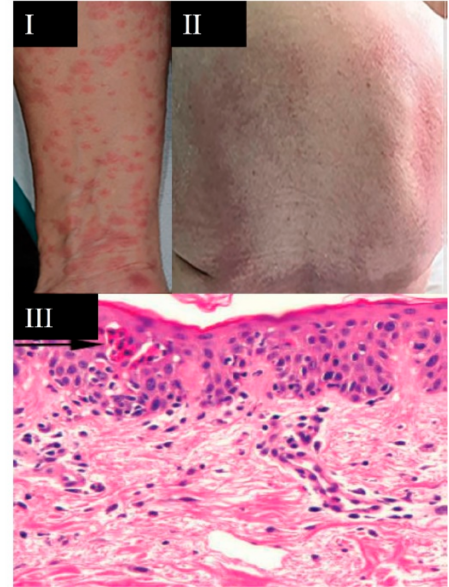
Figure 8. Maculopapular-erythematous rash. ( I ) Maculopapular lesions described as small plaques after fusion of the lesions; ( II ) maculopapular rash appearing on the posterior trunk; ( III ) skin biopsy showing clusters of apoptotic keratinocytes in the epidermis (arrow). Singh H. et al. (2021) ( I , II ) [22] and Arias Arguello A. (2020) ( III )